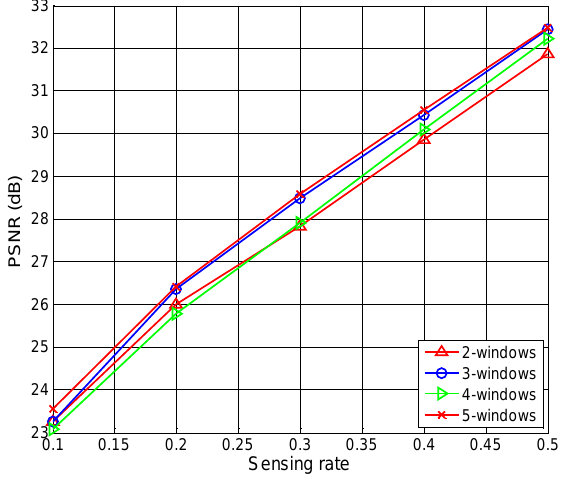
Figure 12. The PSNR performances for different number of